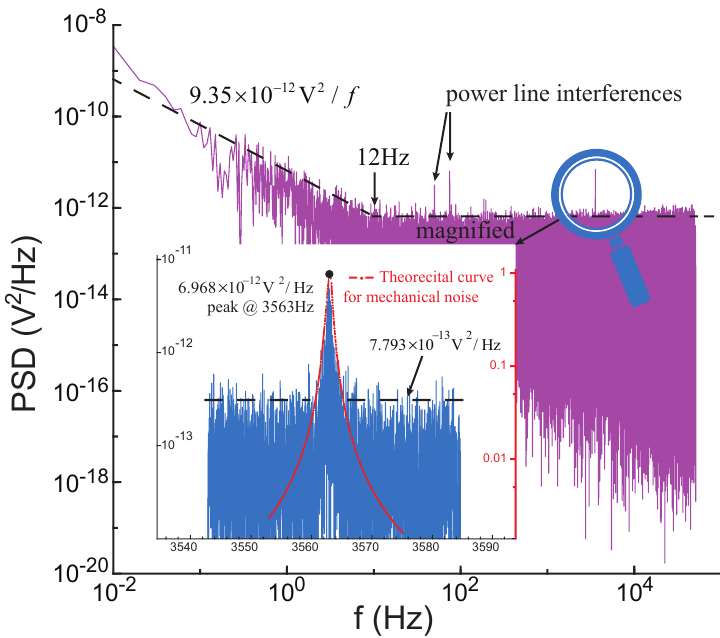
Figure 15. The PSD of the noise in the pickoff circuit. The theoretical curve in the insert was obtained via Equation (18).